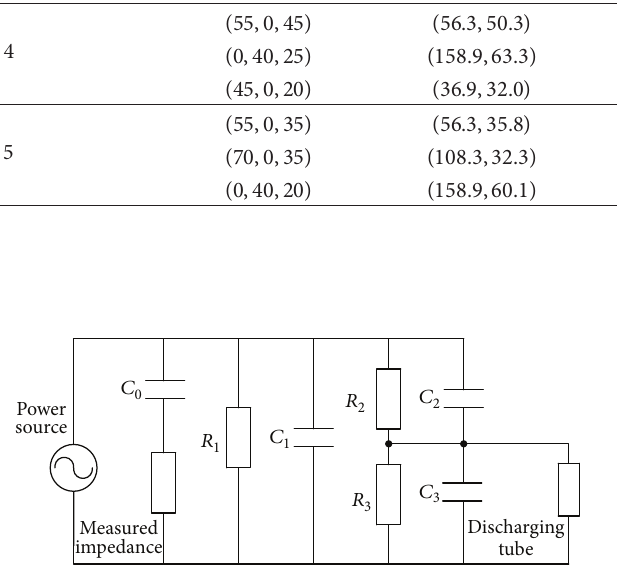
Figure 12: The diagram of the three-capacitor discharge